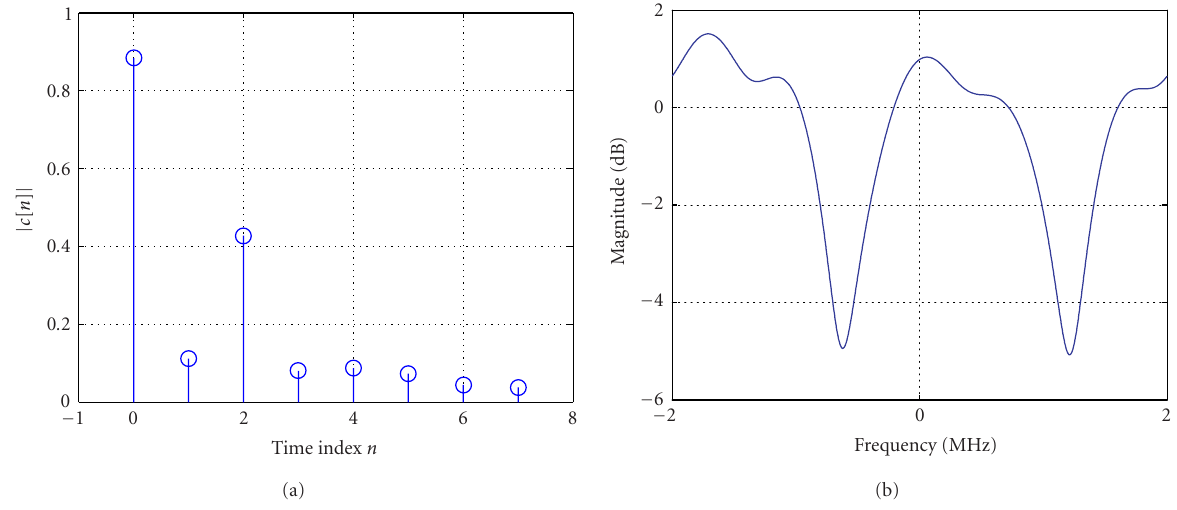
Figure 8: Example for a dispersive baseband channel of the generated ensemble: (a) CIR modulus | c [ n ] | and (b) its magnitude response.